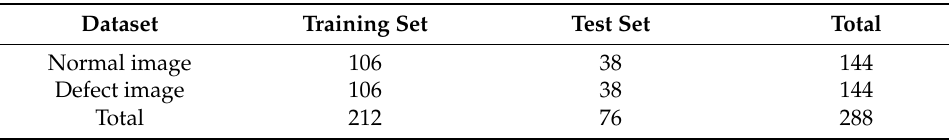
Figure 8. Example of insulator dataset. Table 2. Dataset samples. Table 2. Dataset samples.